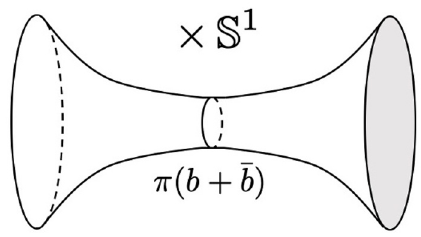
Figure 2 . The wormhole in (3.19). This is a bottleneck geometry, where the length of the bottleneck is π | b + ¯ b | and spinning fields are twisted by an amount determined by b − ¯ b after going around